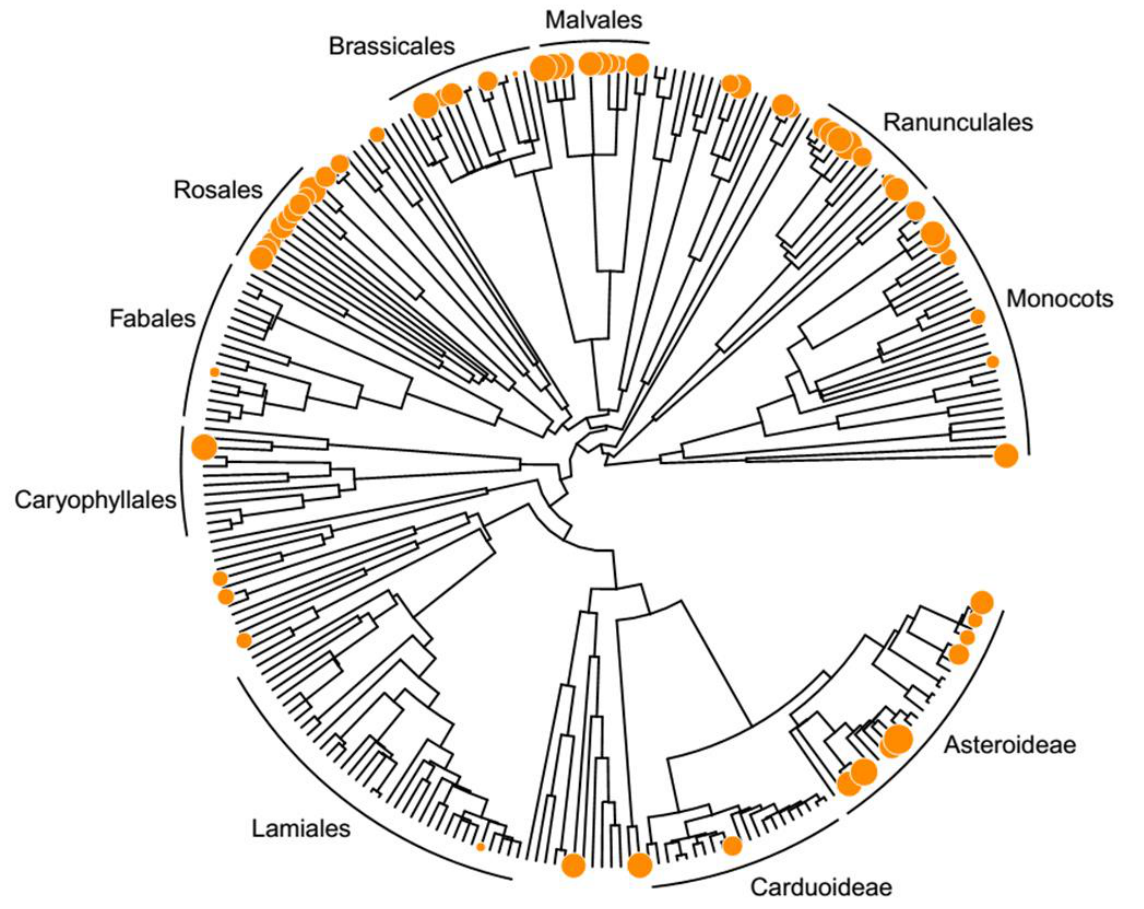
Figure 2. Distribution of flower visitation rates (symbol size) by nitidulid beetles (all species combined) across the phylogenetic tree depicting the evolutionary relationships of the 251 plant species from 46 families studied. Tree tips without symbols denote plant species where Nitidulidae were not recorded.